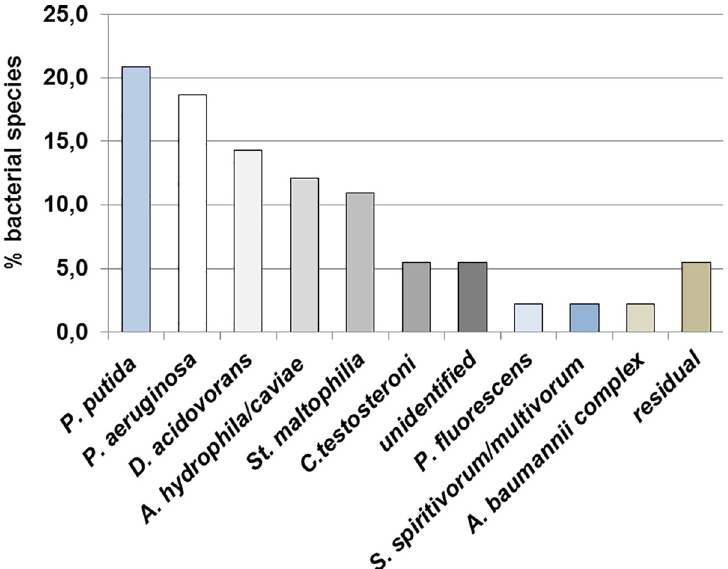
Fig 5. Bacterial species in %, isolated from household environments on ampicillin-selective TSA plates. Species were determined by VITEK 2 system